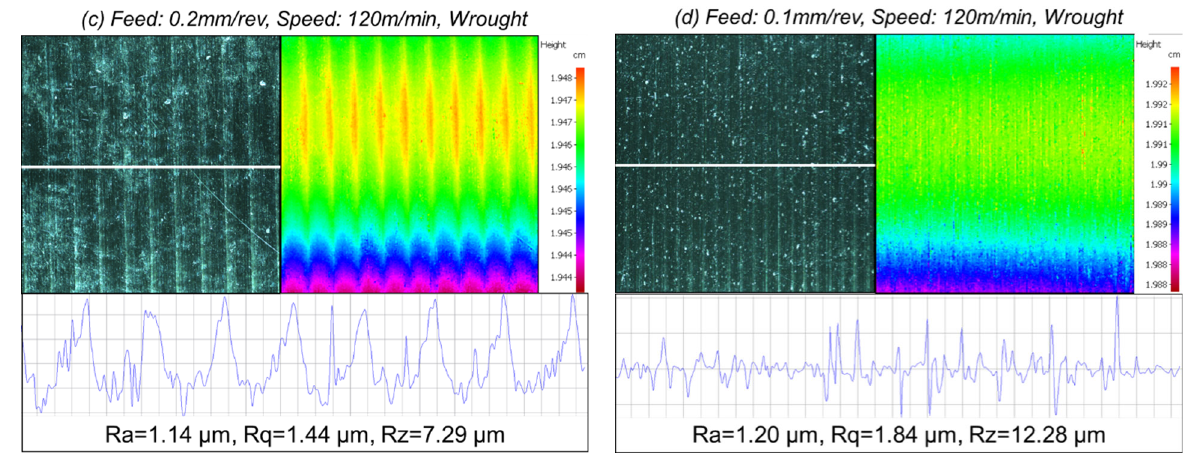
Figure 15. Profile of the machined surface of wrought Ti6Al4V at the cutting depth of 0.5 mm, ( a ) feed rate: 0.1 mm/rev, speed: 80 m/min; ( b ) feed rate: 0.2 mm/rev, speed: 80 m/min; ( c ) feed rate: 0.2 mm/rev, speed: 120 m/min; ( d ) feed rate: 0.1 mm/rev, speed: 120 m/min.